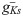
Slow potassium conductance shapes upstate dynamics of individual neurons.(A.) For very low levels of gKs¯ individual upstates of neurons last for a longer and more variable number of spikes (black
data
series). The adaptive effect of the slow potassium conductance is shown by the large variation in ISI for gKs¯ values above 0.75 (Red
data
series). Increasing gKs¯ reduced the number of spikes per upstate to about 3. Data is shown for w
ie = 24 μS/cm
2 and error bars represent standard deviation. (B.) Increasing inhibitory strength, while decreasing wave speed maintains a stable number of spikes per upstate, with average number not changing by more than one (data are mean ± s.e.m).